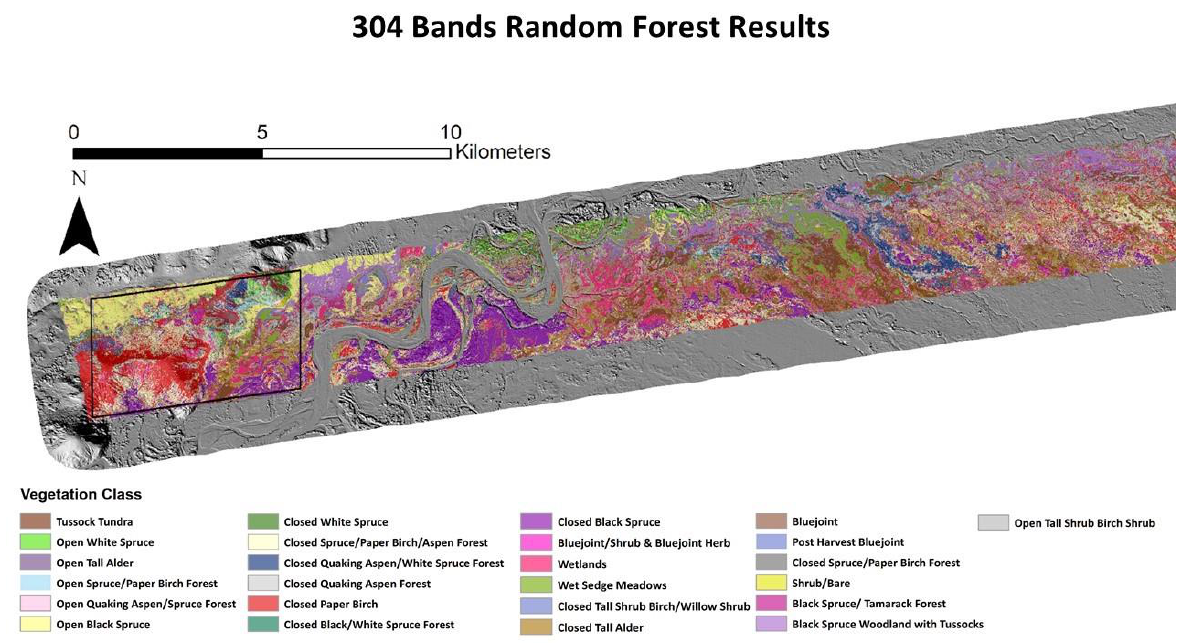
Figure 8. Vegetation Map created from 304 AVIRIS-NG bands using the Random Forest classifier. This product had a ~80% accuracy at Viereck level IV; ~82% accuracy at Alaska Fuel Model Guide Task Group (2018) fuel type.